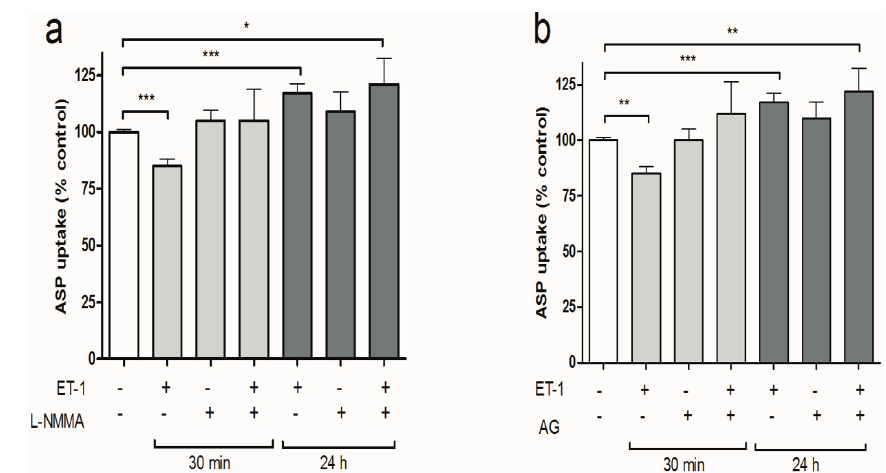
Figure 4. NOS-inhibition reverses the short-term action of ET-1 on ASP + uptake. CiPTEC monolayers were incubated for 15 min in medium containing 10 µM ASP + without or with pre-incubation with ( a ) 100 nM ET-1, 100 μ M L-NMMA or ET-1 plus L-NMMA; ( b ) 100 nM ET-1, 100 μ M aminoguanidine (AG) or ET-1 plus 100 µM AG. Subsequently, the